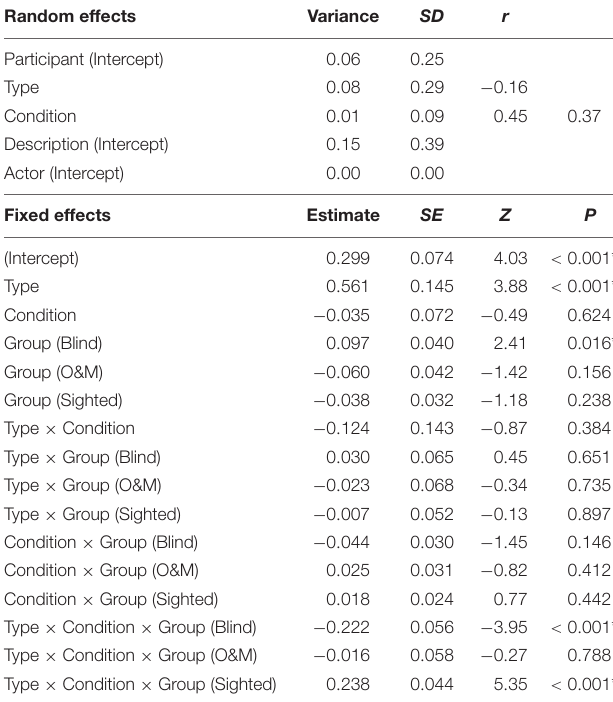
TABLE 4 | The estimates of Model